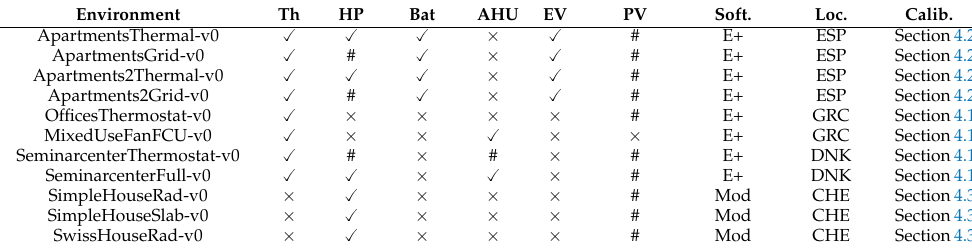
Table 1. Equipment of the different models in Energym. Th: Thermostat, HP: Heat Pump, Bat: Battery, AHU: Air Handling Unit, EV: Electric Vehicle, PV: Photovoltaic. #: present but not controllable, × : absent. The last column refers to the section where the calibration method used for each model is